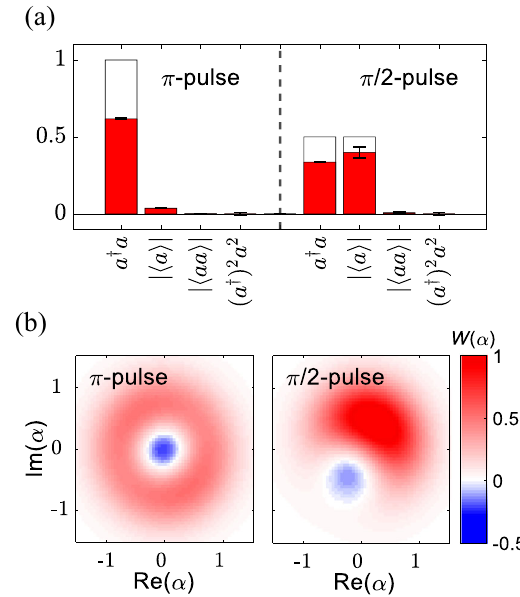
Fig. 3 Moments and Wigner functions. a The bar chart with error bars for two standard deviations shows a comparison between the experiment (red) and theory (white) for the moments of a single- photon state 1 j i after a π -pulse pulse and a superposition state ffiffiffi p ð 0 j i þ 1 j iÞ = 2 after a π /2-pulse. b Wigner functions corresponding to the moments obtained from the experiment in ( a ) using a maximum likelihood method 34,36